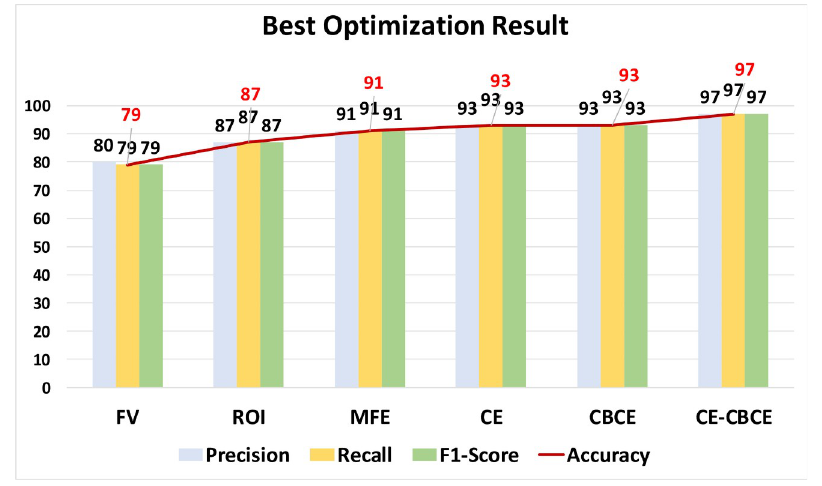
Fig 6. Best optimization result for each feature extraction method.